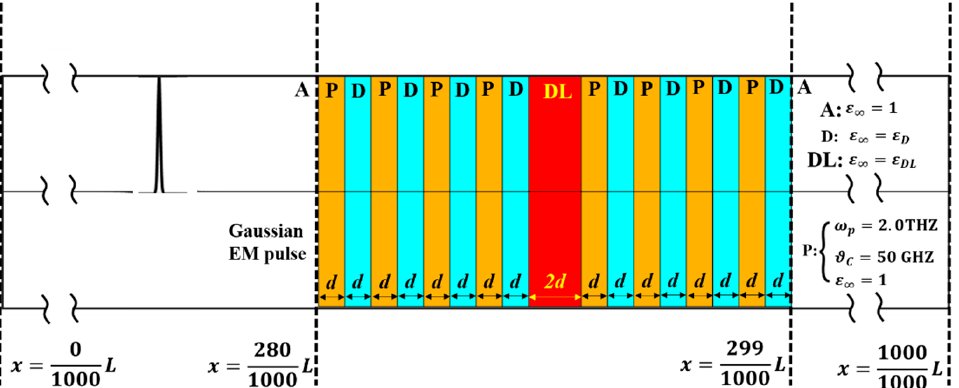
Figure 6. Schematic of an incident Gaussian pulse and computational domain of 1D plasma PhCs with one defect layer.